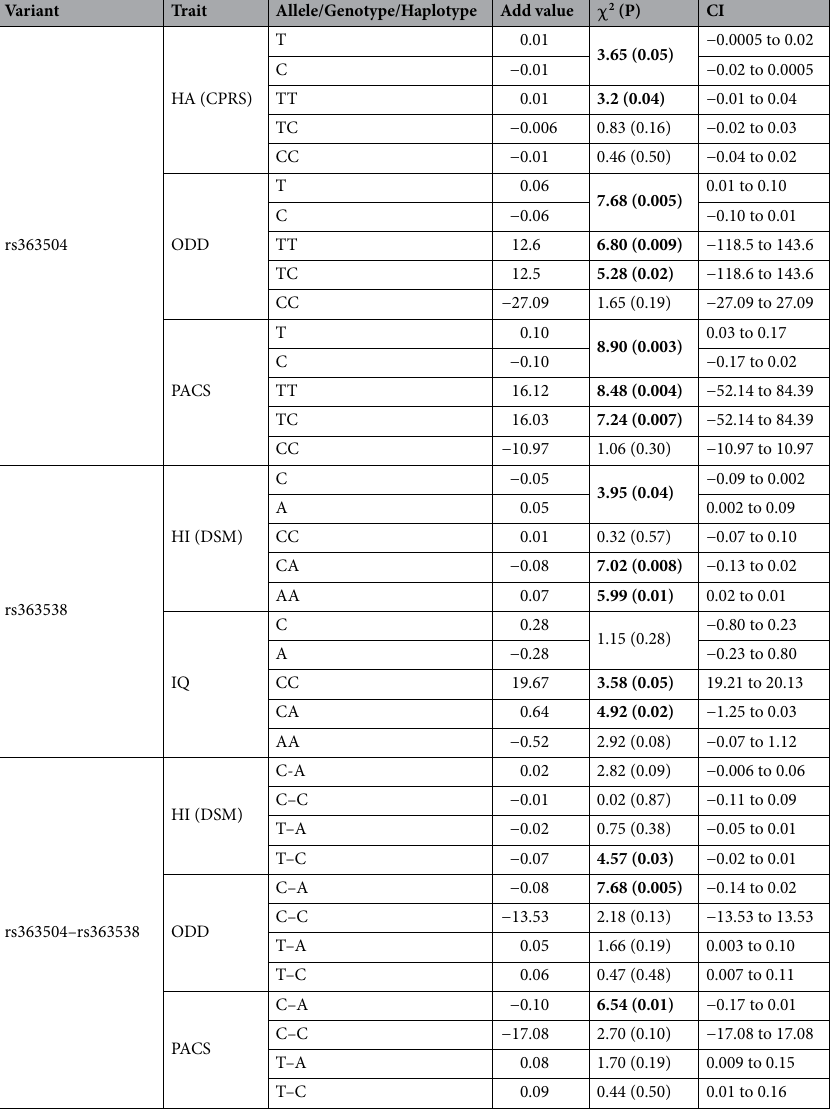
Table 3. Quantitative trait analysis involving gene variants and ADHD-associated traits. N.B: Statistically significant differences are presented in bold. HA(CPRS)- Hyperactivity score (Conner’s Parent Rating Scale- Revised); ODD- Oppositional Defiant disorder, PACS- Parental Account of Children’s Symptoms; HI(DSM)- Hyperactivity/Impulsivity (Diagnostic and Statistical Manual); IQ- Intelligence